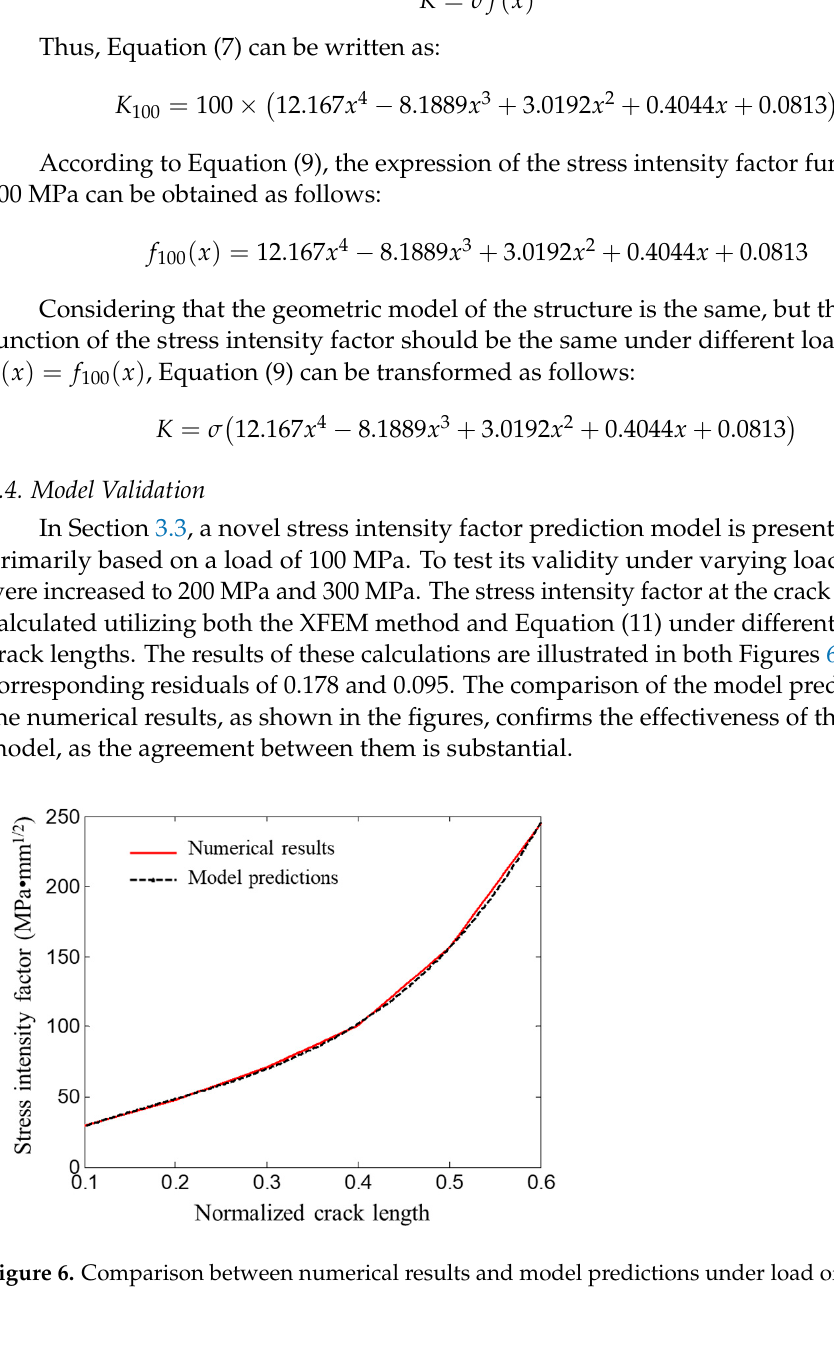
Figure 7. Comparison between numerical results and model predictions under load of 300 MPa. 4. Prediction Model of Central Symmetric Crack Stress Intensity Factor A central symmetric crack is one of the most common crack forms in structural com- ponents. The propagation form of the crack is similar to that of the edge crack, but there are also differences. It has also attracted much attention because it is an important factor leading to failure based on the stress of the component. 4.1. Development of Numerical Model for Crack Calculation The geometry of the cracked component model is defined as a 120 mm × 50 mm × 2 mm structure with an initial crack, measurements of 2a and 5 mm are preset at the center of the component, which is placed symmetrically at its center along a 90° angle parallel to the width direction, as depicted in Figure 8a. The midpoint of the crack coincides with the center of the thin-walled plate, with one end fixed and the other subjected to tensile stress. The numerical model, shown in Figure 8b, uses an eight-node hexahedral element mesh with a matrix element size of 2 mm and a crack tip mesh size of 0.25 mm. The material properties utilized in the calculation can be found in Table 1. The development of the nu- merical model is illustrated in Figure 8b.